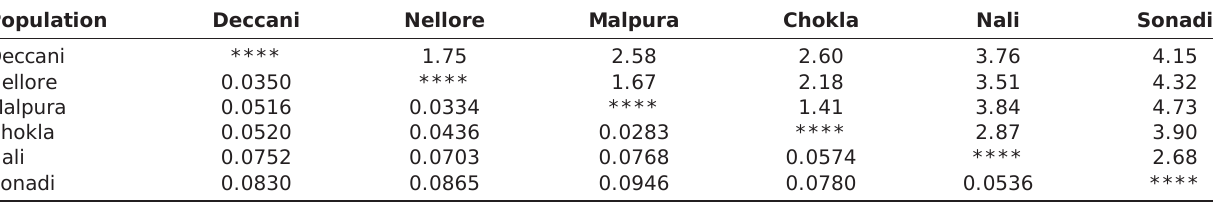
Table-2: Overall genetic distance (below diagonal) and divergence time million years ago (above diagonal) among sheep breeds.